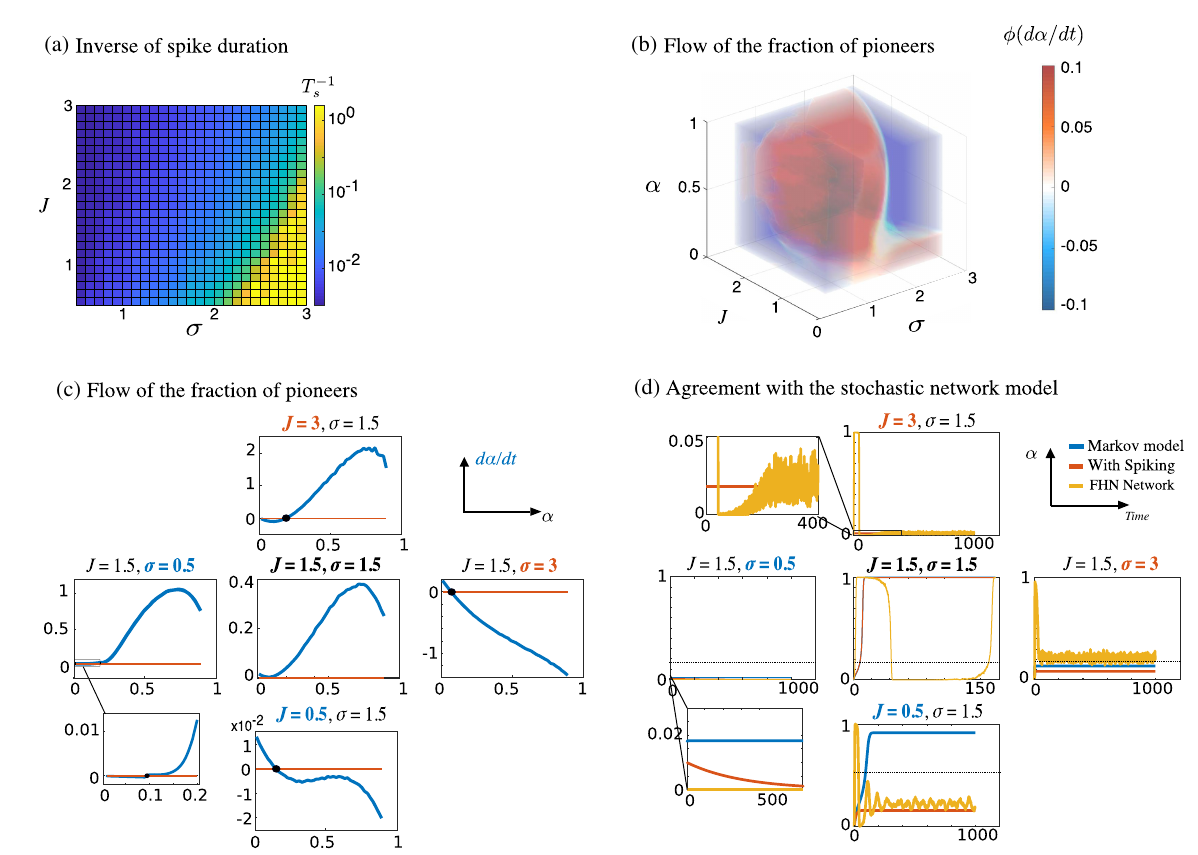
FIG. 4. Stochastic and spiking transitions. Combining stochastic transitions and spiking recovers qualitatively and quantitatively the phenomenology of the stochastic FitzHugh-Nagumo network of Fig. 1. (a) Numerical evaluation of the inverse spike duration [Eq. (6)] as a function of σ and J . (b) Flow of the fraction of pioneers [right-hand side of Eq. (7)] as a function of σ , J , and α (four- dimensional representation using PCOLOR 3 MATLAB routine [77]). The system recovers the clamping fixed point with 0 pioneers in the low-noise or high-coupling regimes, nontrivial fixed points for large-noise or low-coupling regimes, and a uniformly positive flow (chain reaction and noise-induced synchronization) for intermediate values (red spherelike surface). For legibility, the flow was smoothed and thresholded through the function ϕ ∶ x ↦ ½ 1 þ tanh ð 4 x Þ(cid:3) = 2 . (c) Flow of the fraction of pioneer α in the five situations considered in Fig. 1(a), recovers the appropriate dynamics in all cases qualitatively. (d) Number of pioneers in (red) the simplified model (7) taking into spiking, the simplified model neglecting spiking (blue), and the stochastic network (yellow). Good agreement is found with the simplified model when taking into account spiking, deviating significantly from the model neglecting spikes especially at low coupling or low noise. When it exists, the critical fraction of pioneers α associated with the chain reaction is c depicted as a black dashed